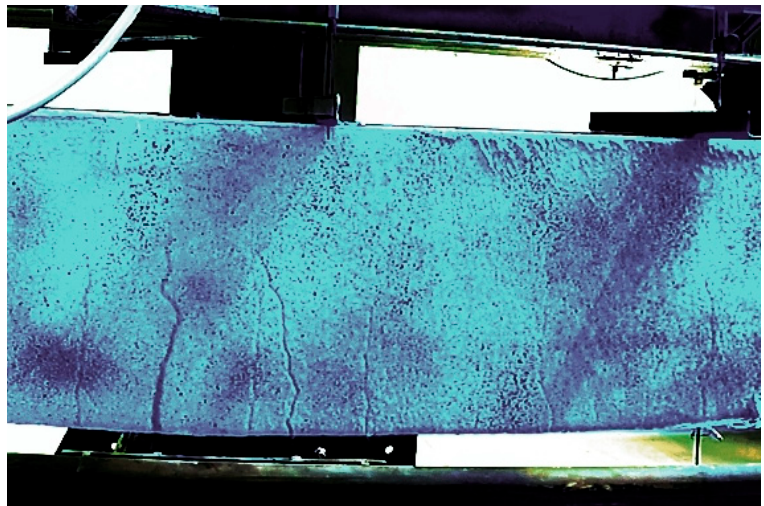
Figure 13. The cracking pattern at the midspan of the polyurea-coated RC beam.